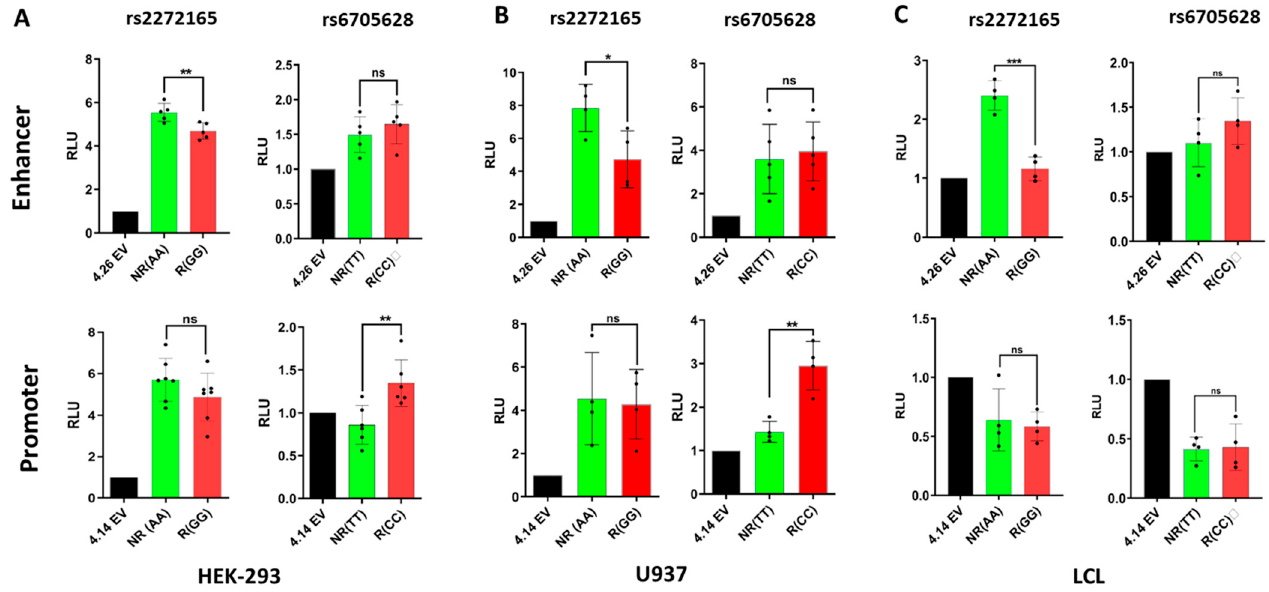
Figure 4. Allele-specific promoter and enhancer activity of the two SNPs, using luciferase reporter assays across ( A ) HEK293 (embryonic kidney cells), ( B ) U937 (monocyte), and ( C ) LCL GM18572 (B-lymphocytes). Empty vector pGL4.21 (EV) was used as reference. NR: non-risk and R: risk alleles; p -values are for Student’s t -test. * p < 0.05, ** p < 0.01, *** p < 0.001.